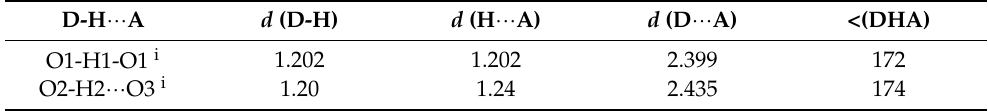
Table 5. Hydrogen bond interactions [Å, ◦ ] for 3 .